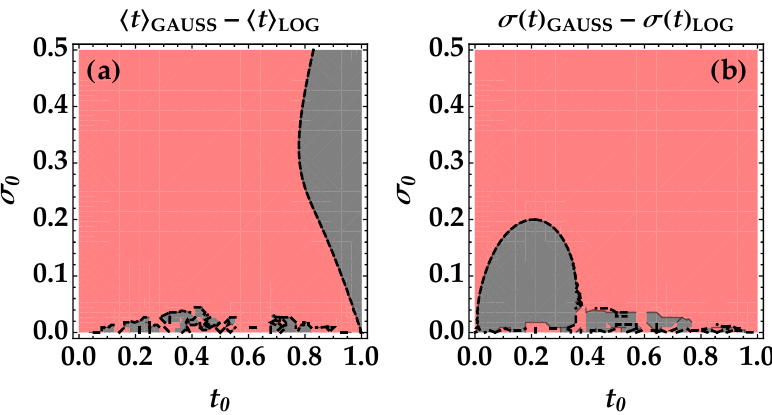
Figure 4. Panel ( a ): Contour plot of the difference (cid:104) t (cid:105) GAUSS − (cid:104) t (cid:105) LOG of the Gaussian and log-normal distributions defined over the interval (0,1) as a function of the mean value t 0 and of the standard deviation σ 0 of the same distributions defined over the entire domain. Panel ( b ): The same as ( a ) for the difference σ ( t ) GAUSS − σ ( t ) LOG . In both panels, the black-dashed line corresponds to the condition in which the difference is equal to 0, the pink region to values larger than 0 and the gray region to values lower than